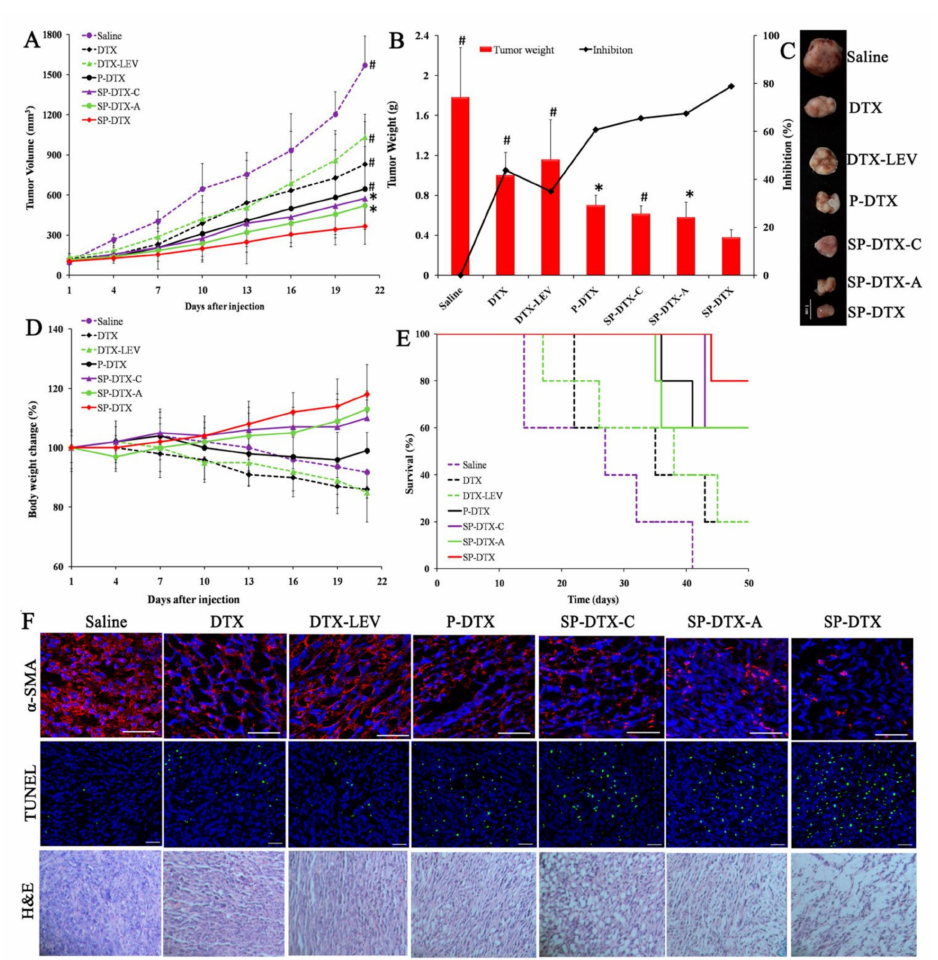
Figure 2. In vivo anticancer efficacy of various DTX formulations. ( A ) Tumor growth curves after intravenous injection of either saline, DTX, DTXLEV, P-DTX, SP-DTX-C, SP-DTX-A, or SP-DTX on mice bearing stroma-rich prostate xenograft tumors every 5 days for four times (5 mg/kg DTX). At the end of experiment, ( B ) isolated tumors were weighed and ( C ) photographed. ( D ) Body weight changes and ( E ) survival rates were monitored. ( F ) Effects of different treatments on the inhibition of CAF growth by α -SMA staining (red), the induction of apoptosis by TUNEL staining (green), and the histological examination by H&E staining of tumor tissues. Blue signal derived from nuclei stained by DAPI ( n = 5, * p < 0.05, # p < 0.01 vs. SP-DTX). Reprinted with permission from ref. [92]. Copyright 2016 American Chemical